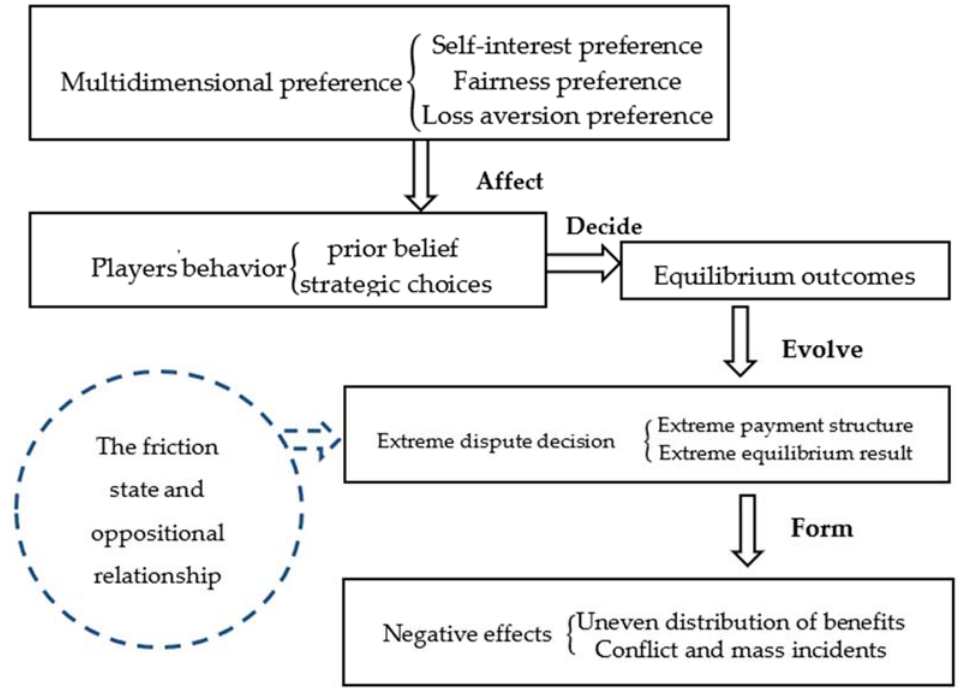
Figure 1. Game analysis framework of extreme dispute decision-making for large-scale engineering projects.